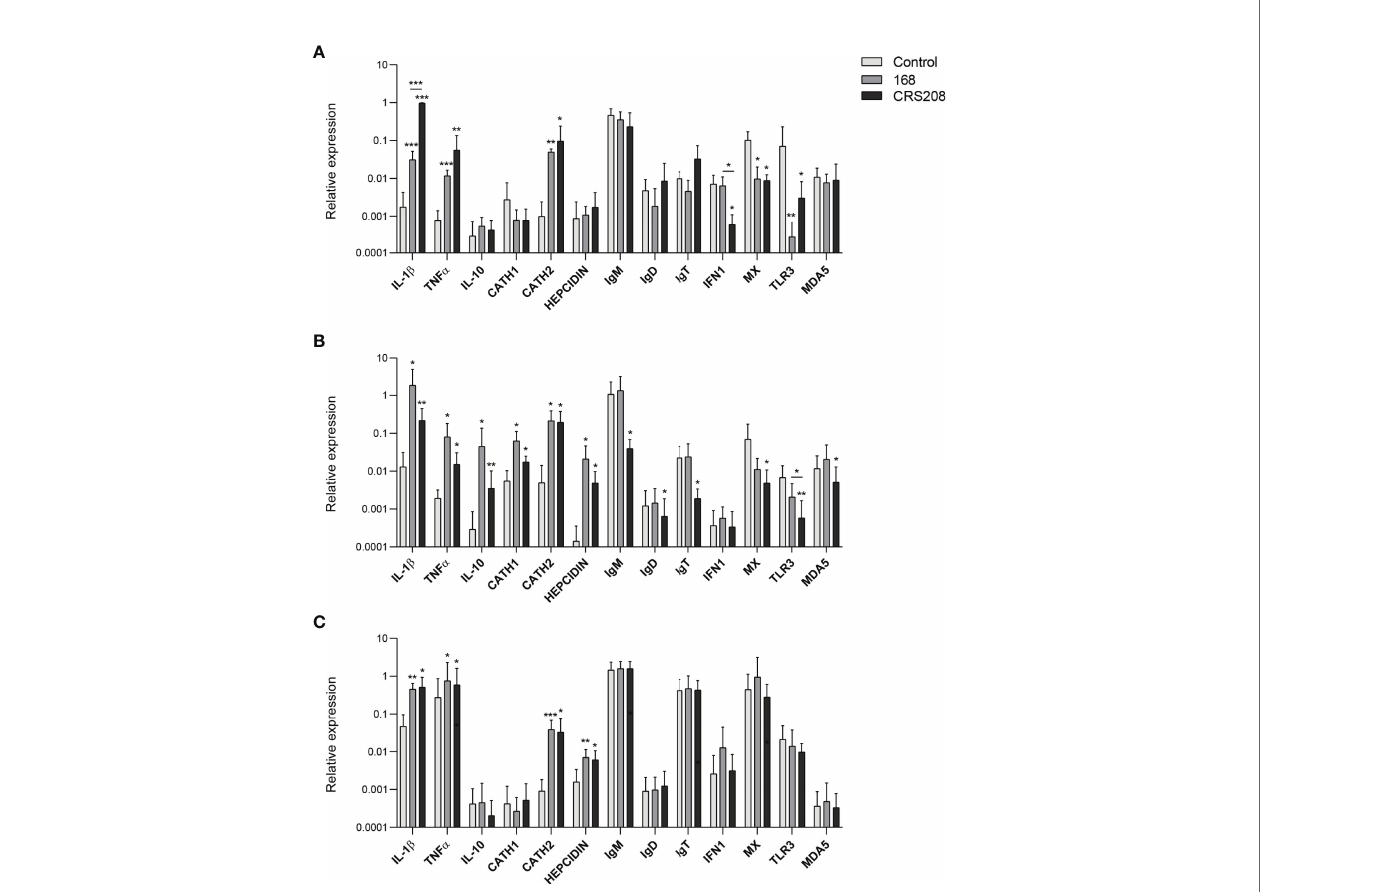
FIGURE 4 | Transcriptional response of leukocytes to B. subtilis strains 168 and CRS208. Spleen (A) , head kidney (B) and peritoneal (C) leukocytes were incubated with 1x10 7 cfu/ml of B. subtilis 168 or CRS208 during 24 h at 20°C. Controls not treated with bacteria were also included. RNA was extracted and the levels of transcription of different genes analyzed by real time PCR. Data are shown as the mean relative gene expression normalized to the transcription of the housekeeping gene EF-1 a + SD (n=8). Statistical analyses were performed by ANOVA and a post hoc comparison by Tukey´s multiple comparison test. The normal distribution was con fi rmed using the Shapiro-Wilk test, and non-normal data were transformed using a ln(Y). Asterisks denote signi fi cant differences in stimulated cultures compared to control cultures, and underlined asterisks show signi fi cant differences between the two bacterial strains, where * p ≤ 0.05, ** p ≤ 0.01 and *** p ≤